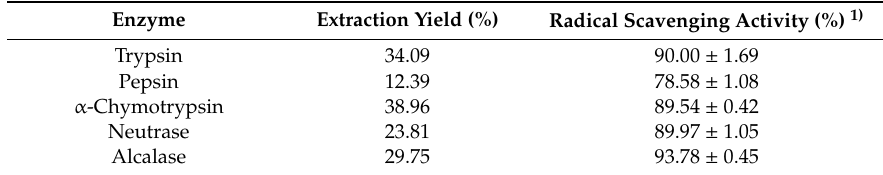
Table 1. Extraction yield and peroxyl radical scavenging activities of enzymatic hydrolysates from velvet antler.